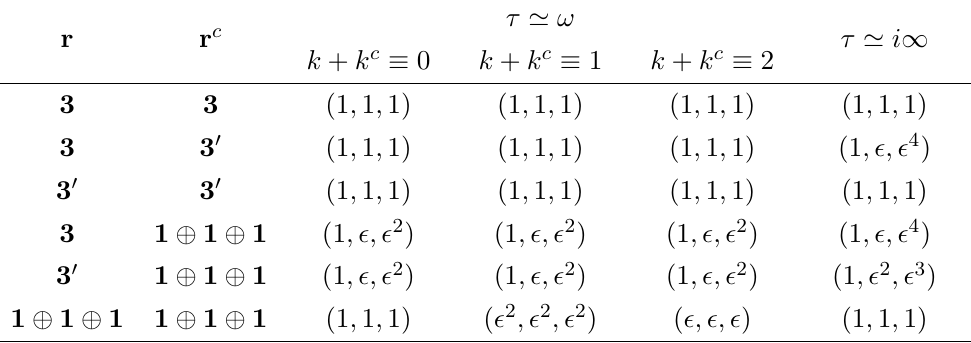
Table 13. Leading-order mass spectra patterns of bilinears ψ c ψ in the vicinity of the symmetric points ω and i ∞ , for 3d multiplets ψ ∼ ( r , k ) and ψ c ∼ ( r c , k c ) of the finite modular group Γ 0 = SL(2 , Z ) . Spectra are insensitive to transposition, i.e. to the exchange ψ ↔ ψ c . ’ A 0 5 5 5 Congruence relations for k + k c are modulo